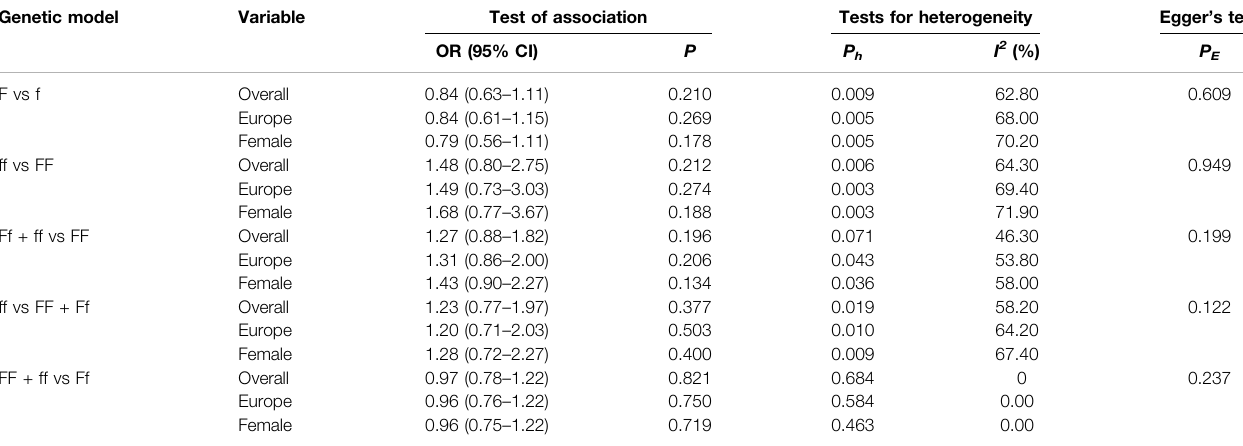
TABLE 10 | Pooled estimates of association of VDR FokI polymorphism and the risk of osteoporotic fracture. Genetic model Variable